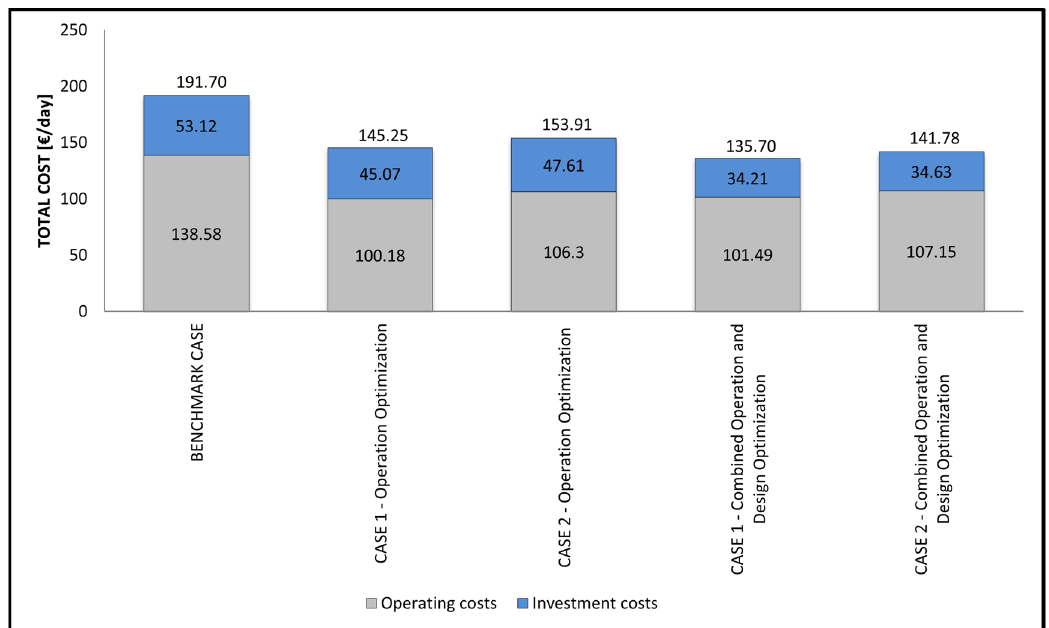
Figure 17. Daily cost for operations and investment for the Operational Optimization (for both Case 1 and Case 2) and Combined Design and Operation Optimization (for both Case 1 and Case 2) with a biogas price equal to 0.39 €/m 3 .